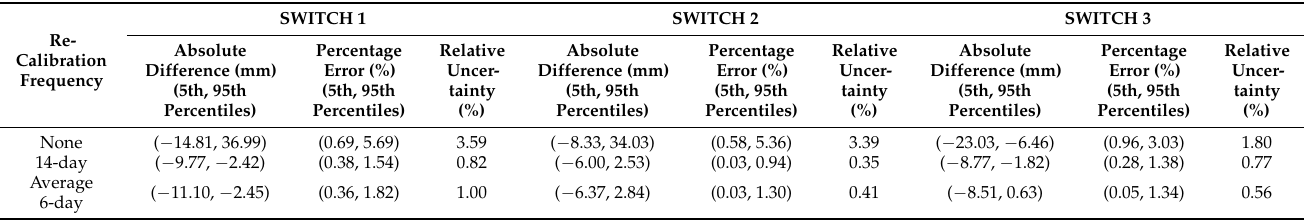
Figure 5. Time series plots of the absolute level difference between low-cost sensor measurements and the interpolated true measurements of water depth for ( a ) IN-WATER 1–3 and ( b ) SWITCH 1–3 sensors; For reference, the true measurement points and interpolated data are shown at the top. Table 1. The absolute error, percentage error and the relative uncertainty of all three SWITCH sensors under different sensor re-calibration frequency (i.e., no re-calibration, 14 days, and average 6